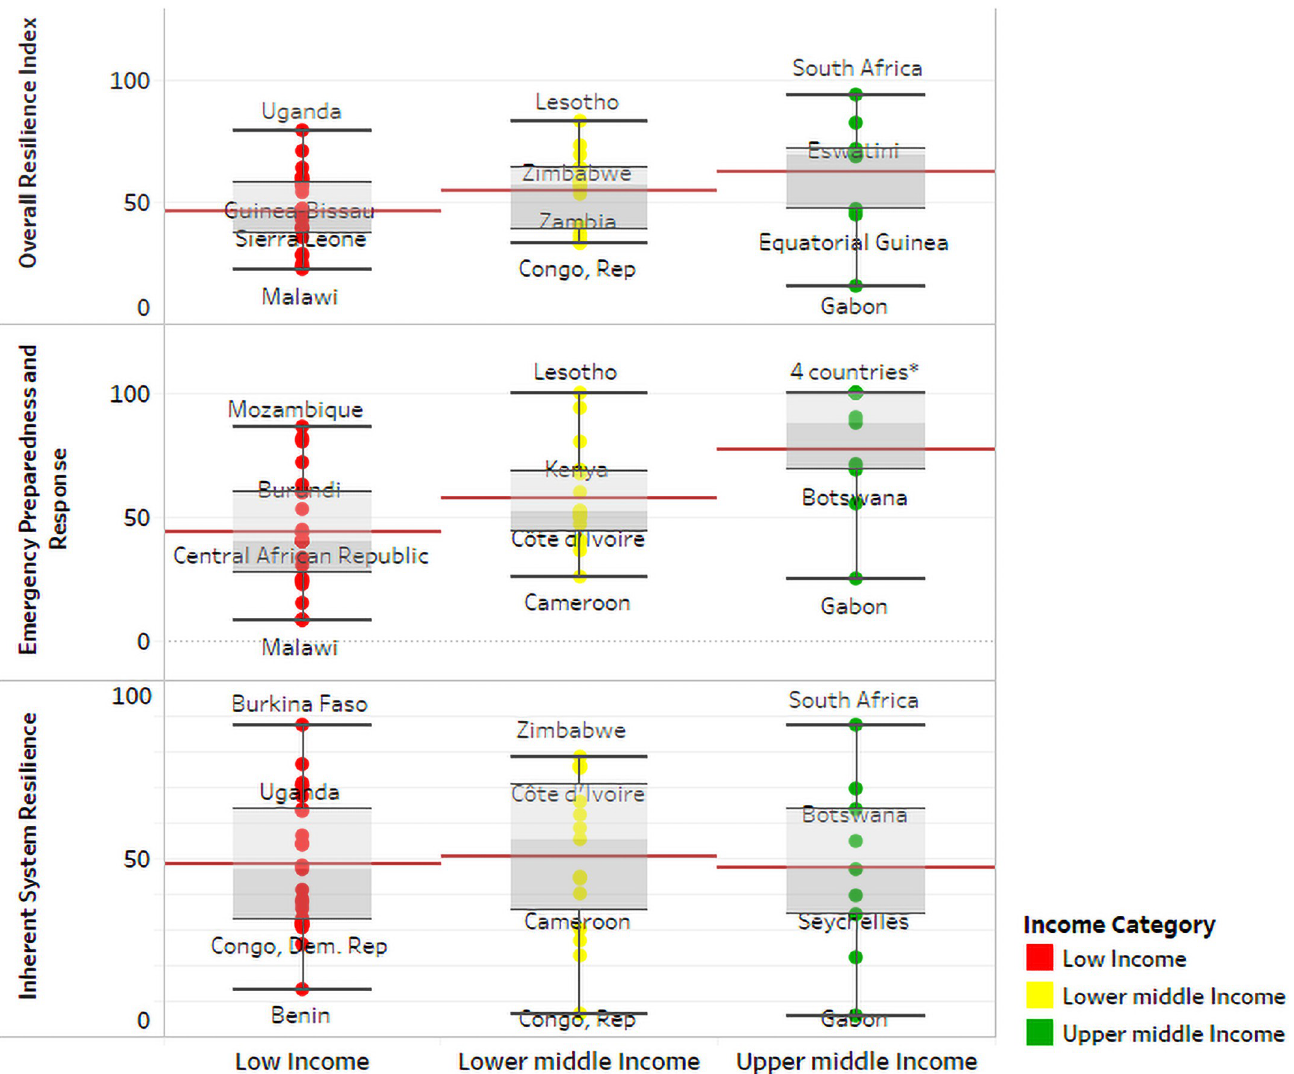
Fig 4. Distribution of inherent system resilience, emergency preparedness and response and overall resilience, by income group in the WHO African Region. � —Four countries with maximum EPR scores are Eswatini, Lesotho, Seychelles and South Africa. Countries displayed on figure represent maximum, 75 th percentile, 25 th percentile and